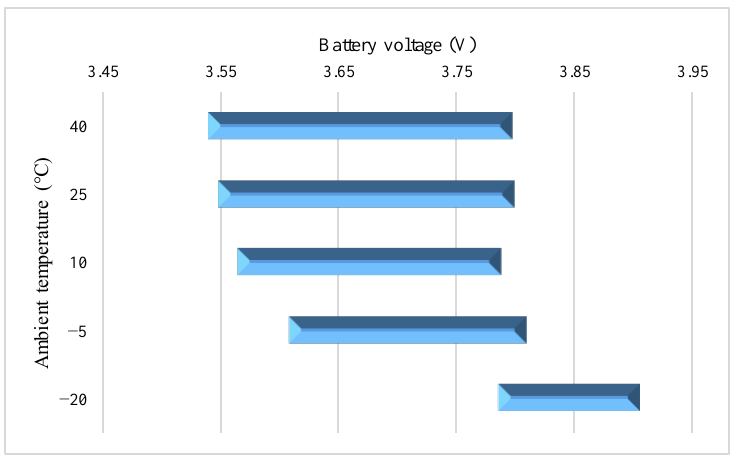
Figure 10. The voltage fluctuation intervals during the VPP with 0.25C charging.